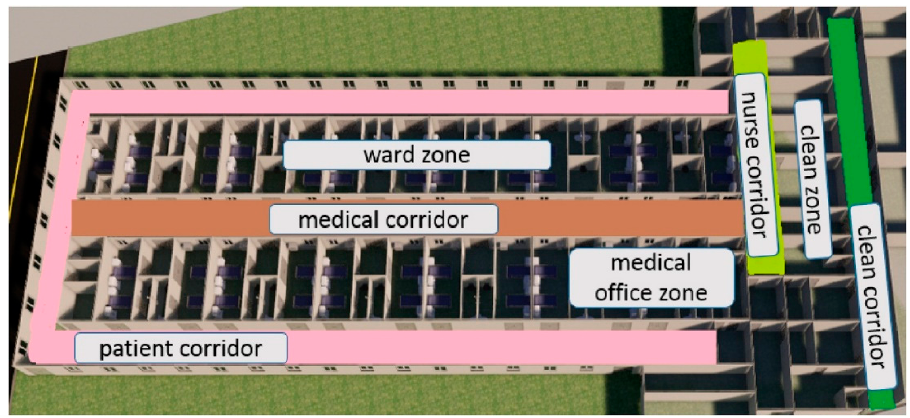
Figure 7. The 3-zone and 4-corridor design arrangement of nursing venues (Adapted from [66]).